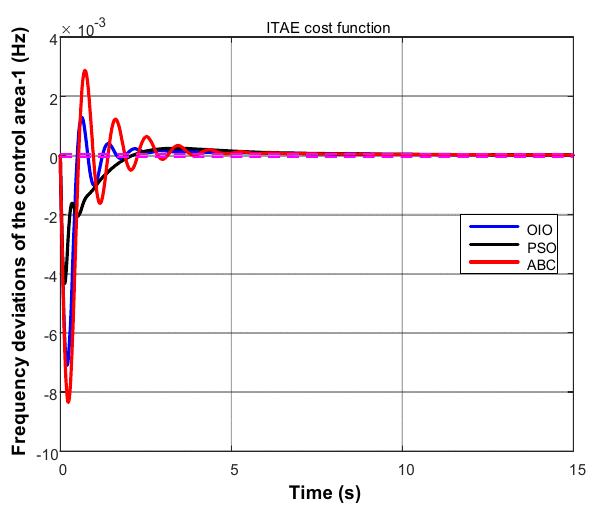
Figure 3. Change in frequency of area ‐ 1 for ITAE.